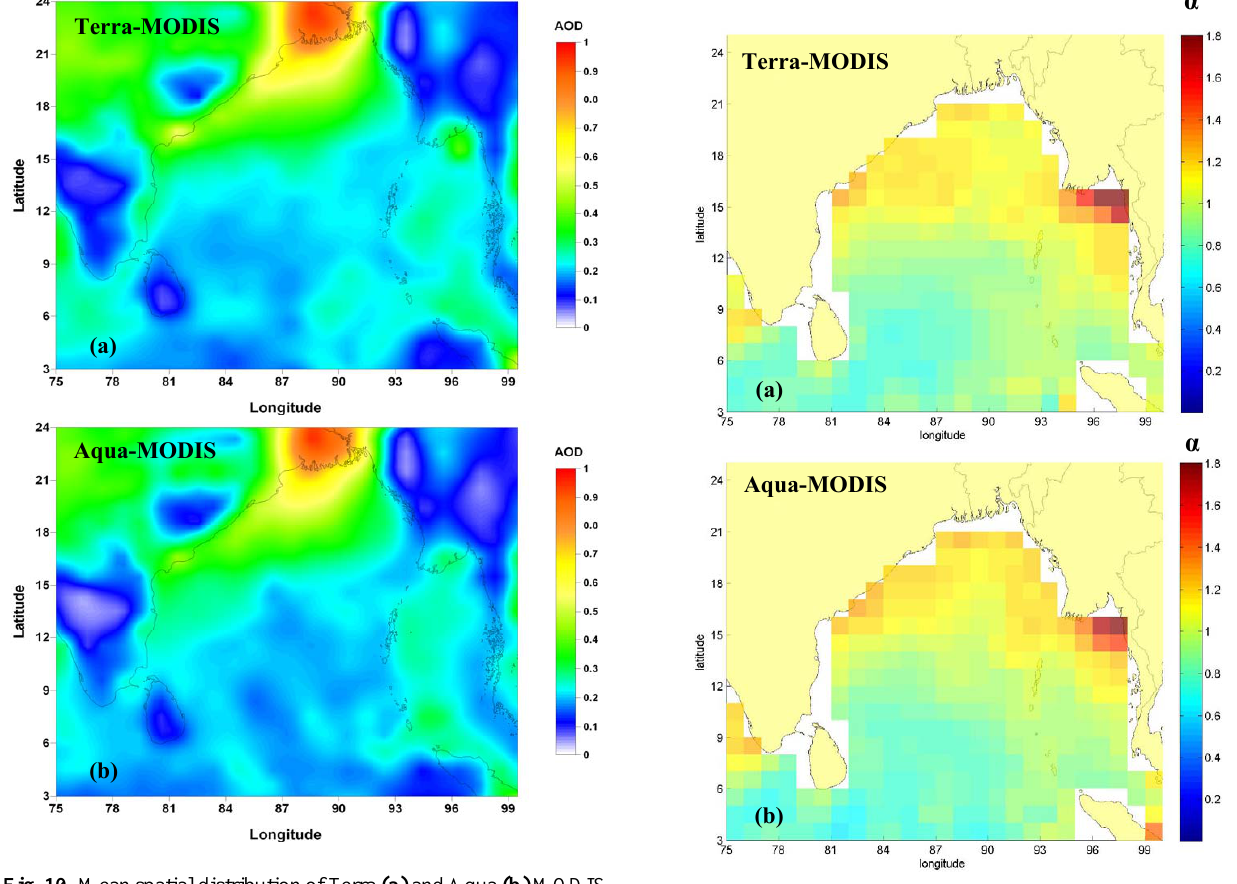
Fig. 11. Same as in Fig. 10, but for the Angstrom exponent α 550 − 865 . 38 be considered qualitative and not quantitative. The mean MODIS AOD 550 shows enhanced values over northern BoB, along the east Indian coast, and in the far east BoB in close agreement with the ship-borne measurements. Note also the similarity between satellite and ship-borne observations re- garding the lower AOD 550 in central-south BoB and close to Myanmar coast. Furthermore, the daily Terra and Aqua MODIS AOD 550 values are similar with a correlation coef- ficient of 0.9 and mean values of 0 . 35 ± 0 . 12 for Terra and 0 . 32 ± 0 . 12 for Aqua. Similarly, Fig. 11a, b shows the mean spatial distribution of Terra/Aqua MODIS α 550 − 865 over BoB using the ocean algorithm. Higher α 550 − 865 values are observed over north, west, and east BoB, but lower (in general < 0.7) values in central and southern parts of BoB and NIO, consistent with the cruise observations (Fig. 4b). The two MODIS sen- sors reveal a similar spatial distribution and mean value of 0 . 99 ± 0 . 18 for Terra and 0 . 98 ± 0 . 19 for Aqua; their be- tween correlation is associated with 75 % of the variance, lower than that found for AOD 550